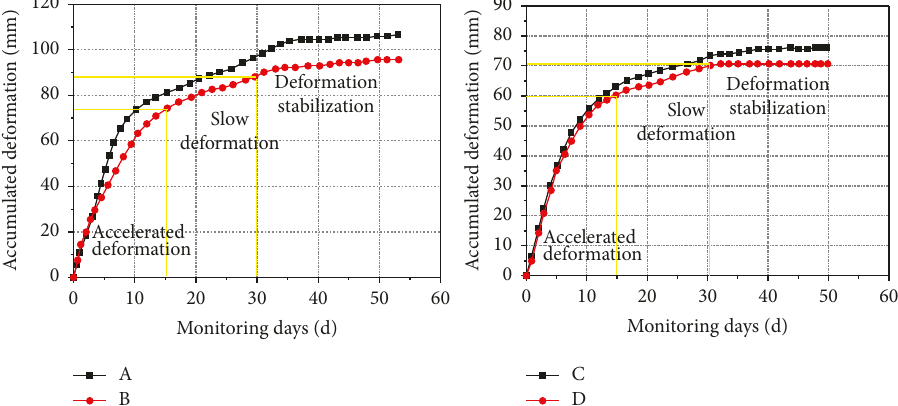
Figure 15: Displacement-time